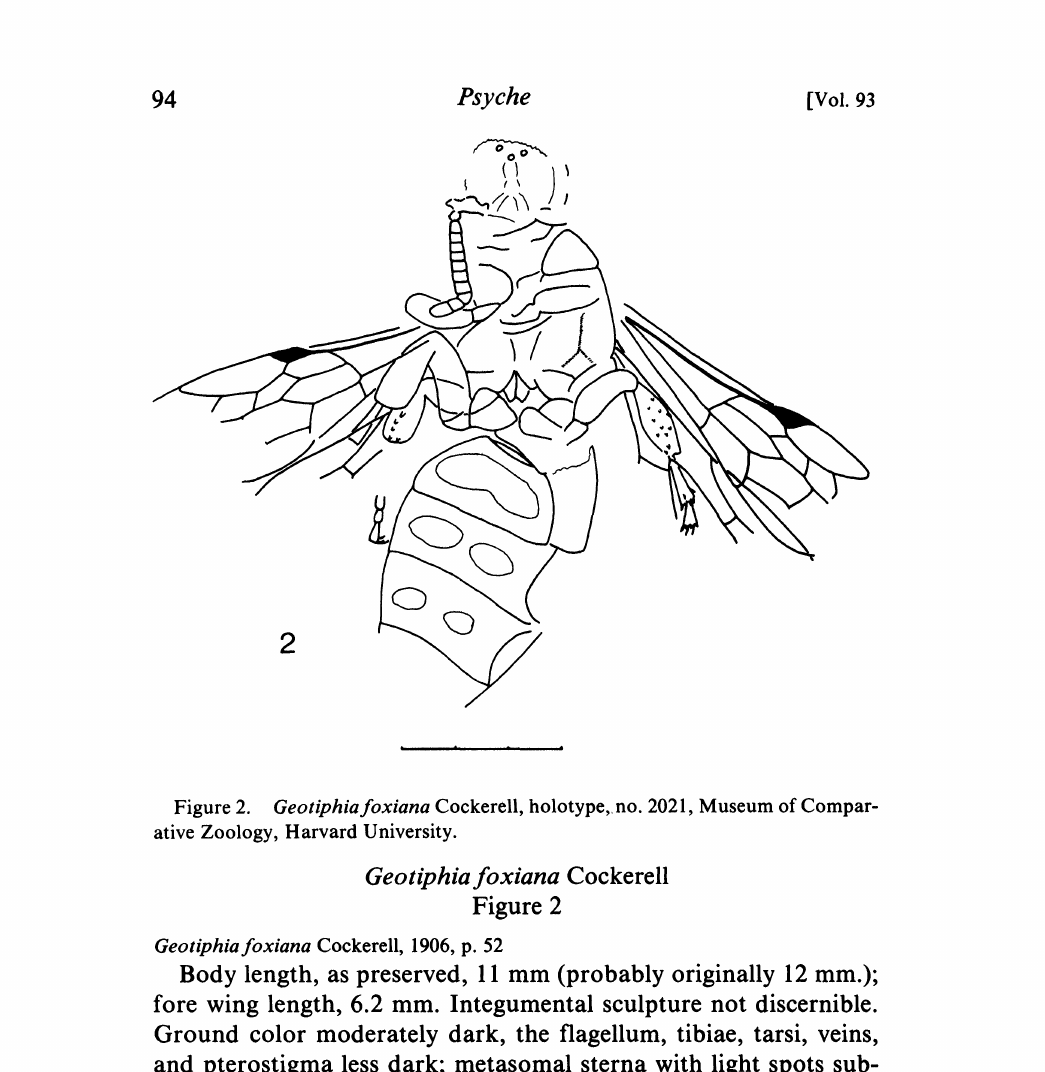
Geotiphiafoxiana Cockerell, 1906, p. 52